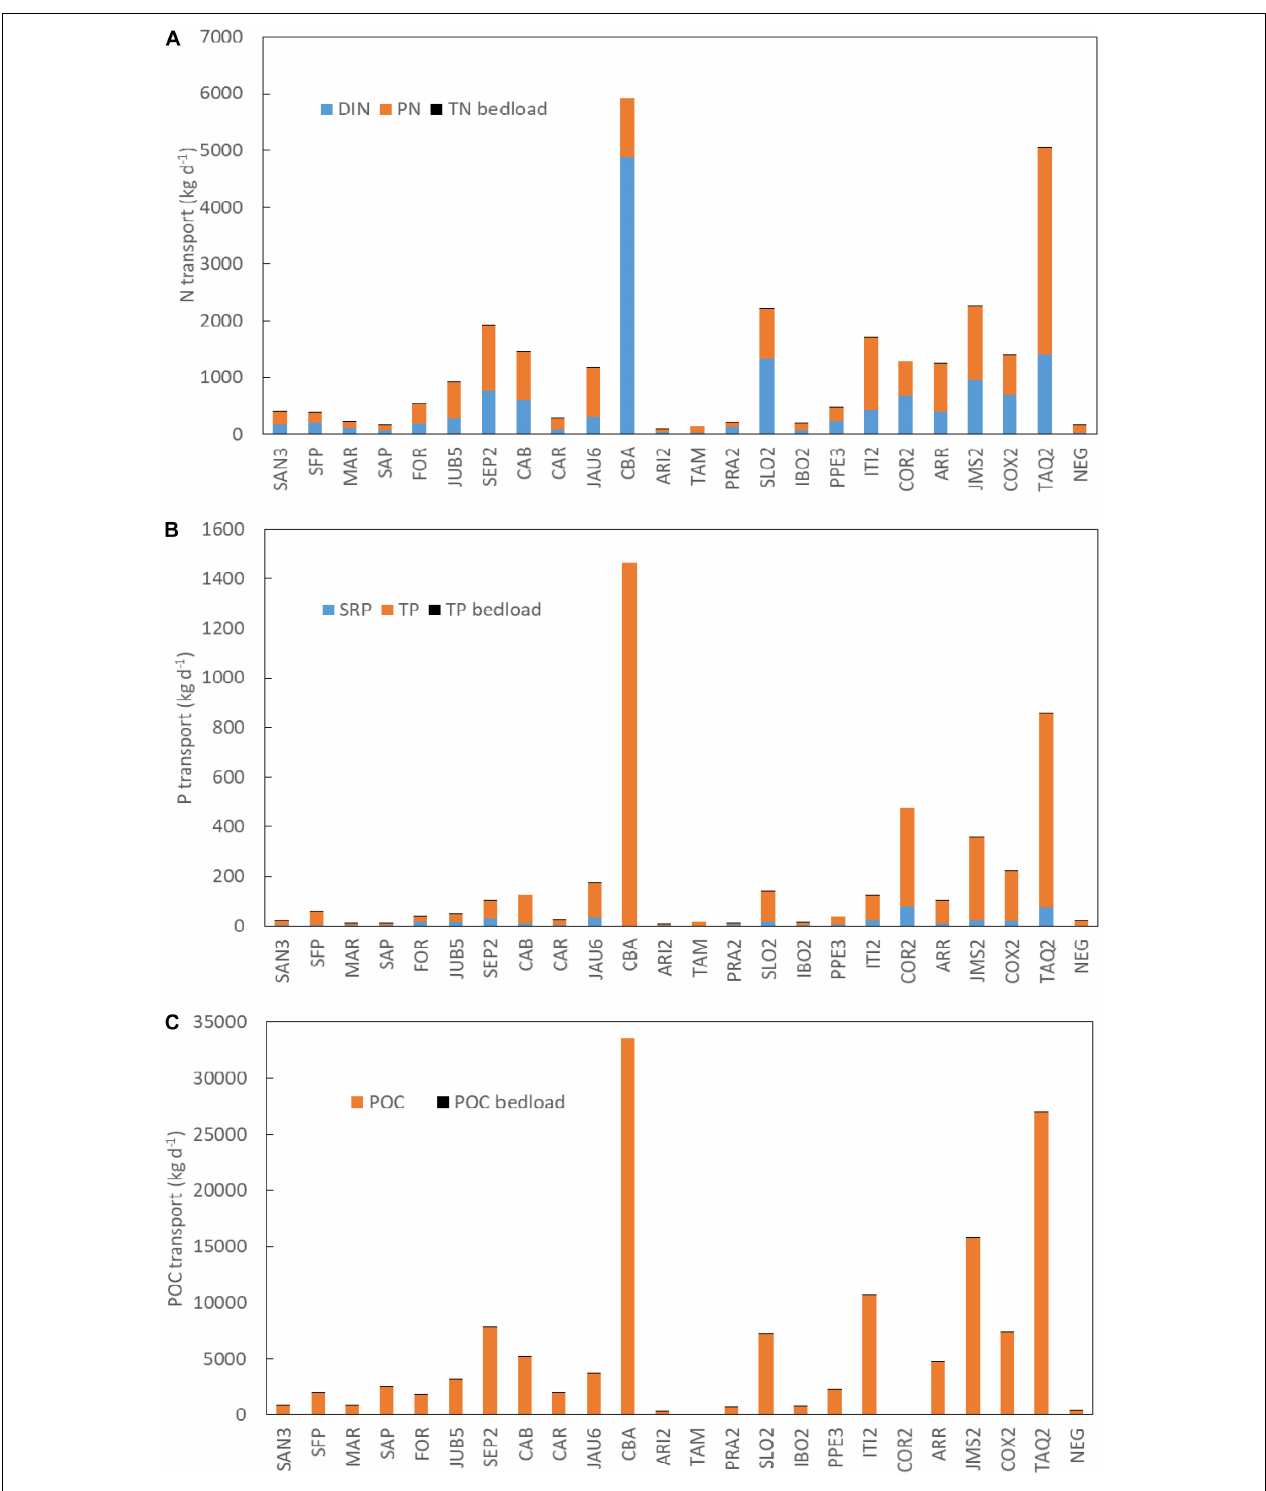
FIGURE 3 | Riverine transport of TN (A) , TP (B) , and POC (C) , with bars divided into dissolved, suspended, and bedload fractions, and of suspended and bedload POC. DIN is the sum of nitrate and ammonium. Bedload estimates, which are hardly large enough to be visible where they exist, were not made for sites CAB, TAM, PPE3, and COR2. Codes indicate the sampling points detailed in Table 1 . The figure includes both primary and secondary data and reaches with current hydropower facilities as well as reaches targeted for future facilities.